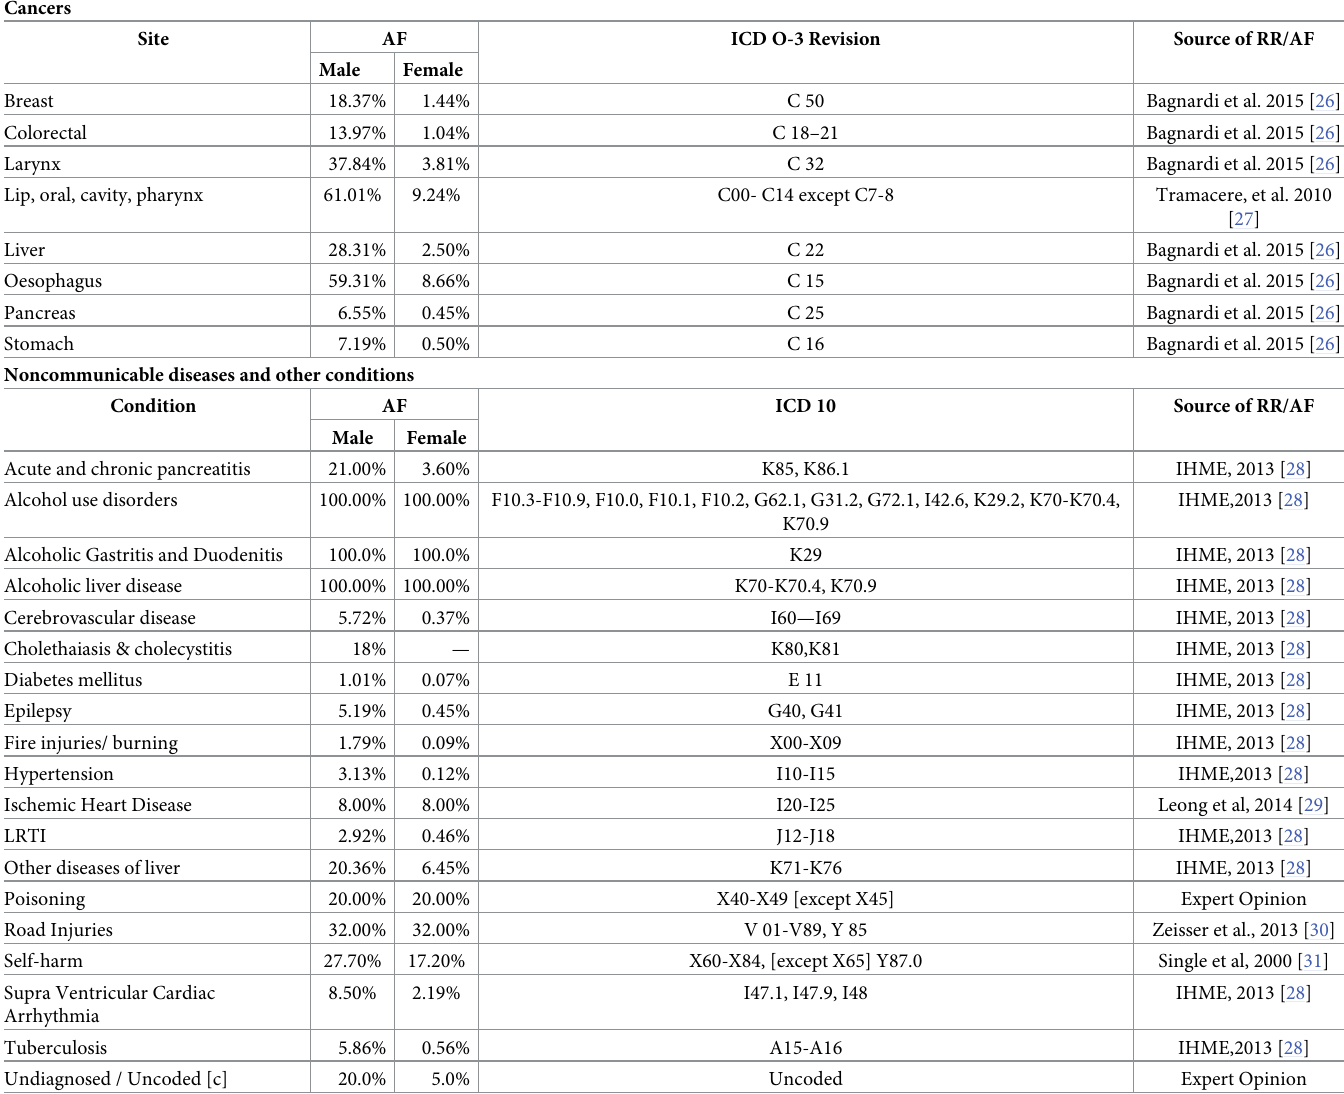
Table 1. Attributable fractions used for morbidity due to